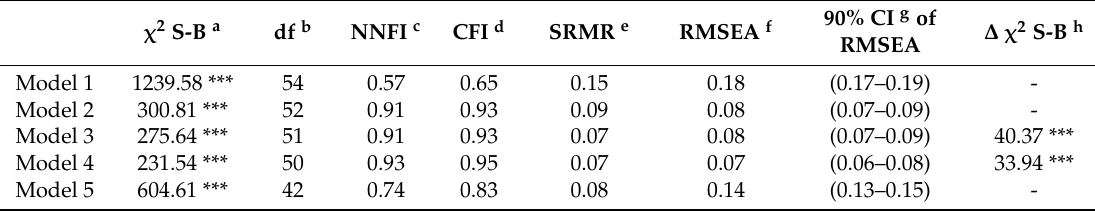
Table 1. Goodness of fit indices for the tested models.